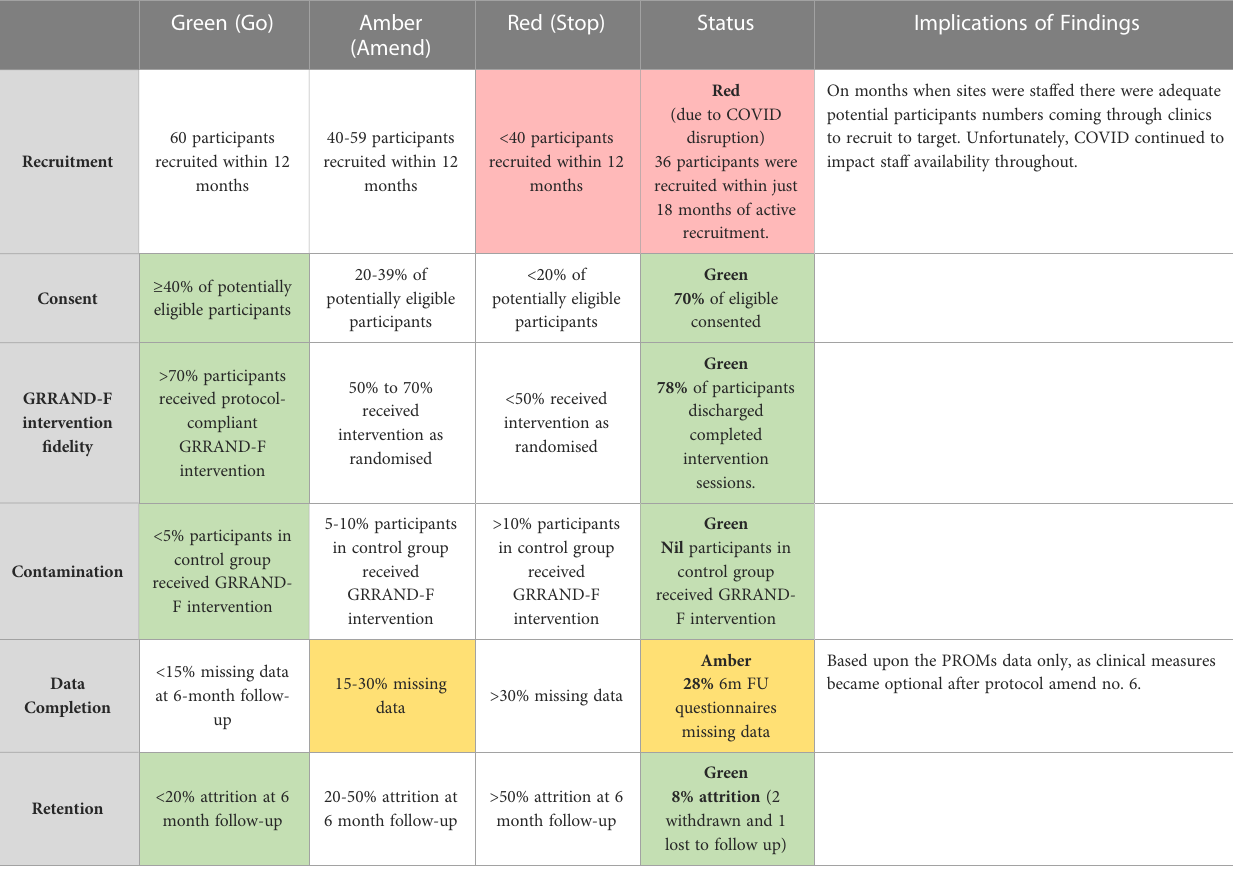
TABLE 5 A summary of the results of the progression criteria based on the traf fi c-light stop-go criteria